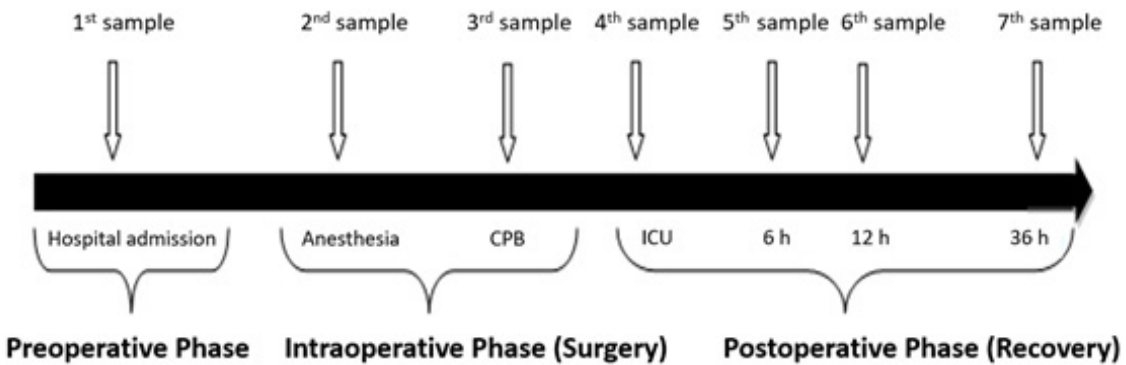
Fig. 1 - Graphical representation of seven blood samples collected for analysis in different phases of the perioperative